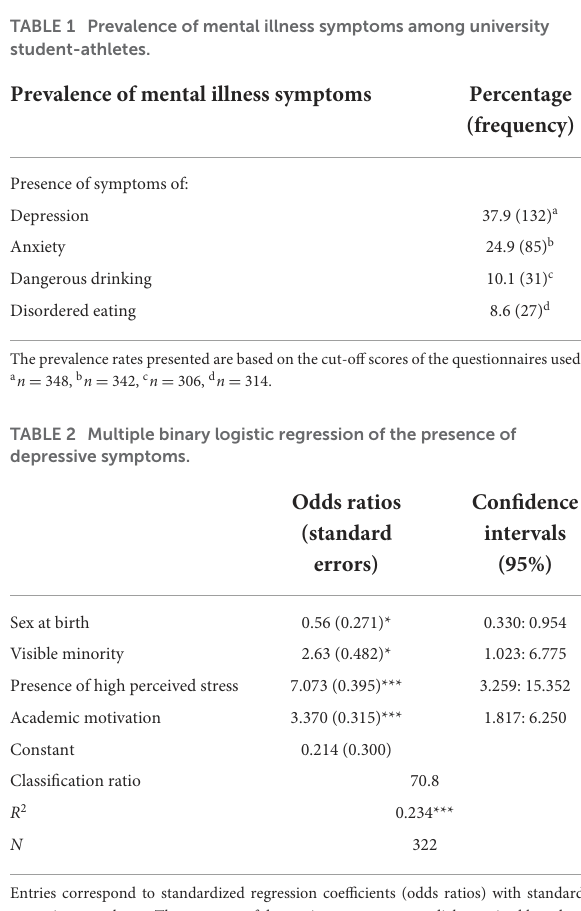
TABLE 1 Prevalence of mental illness symptoms among university student-athletes.